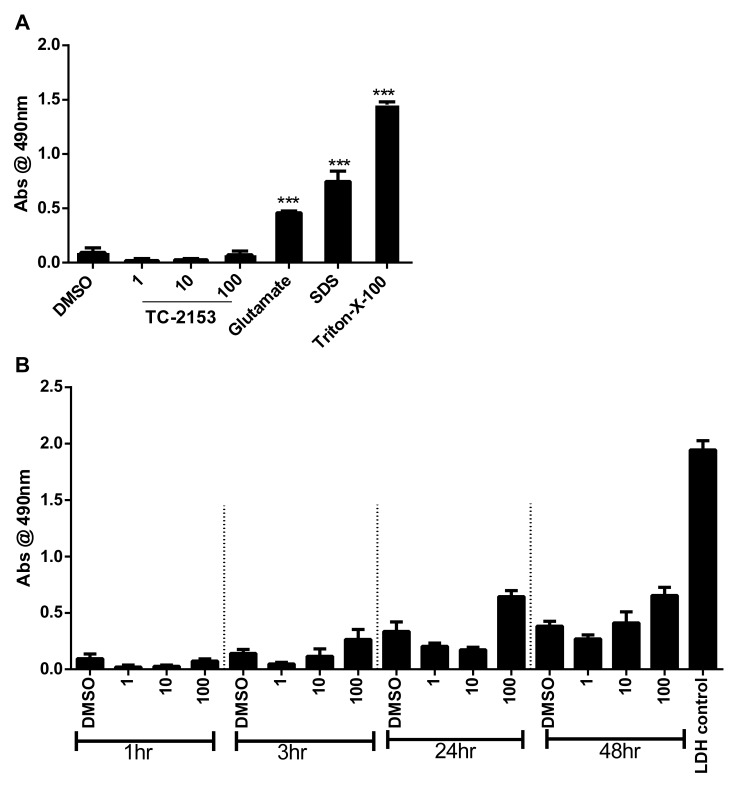
TC-2153 does not induce neuronal cell death.Cortical cells were incubated with TC-2153 (1, 10, and 100 µM) for 1 h along with positive controls: glutamate (100 µM), SDS (0.02%), and Triton-X-100 (0.15%) (A), and at multiple time points (1 h, 3 h, 24 h, and 48 h) (B). Bovine LDH was used as a LDH-positive control. The media was collected and analyzed for LDH. The assay quantitatively measures LDH, a stable cytosolic enzyme that is released upon cell lysis. Released LDH in culture supernatants is measured with a 30-min coupled enzymatic assay, which results in the conversion of a tetrazolium salt (INT) into a red formazan product. The amount of color formed is proportional to the number of lysed cells.